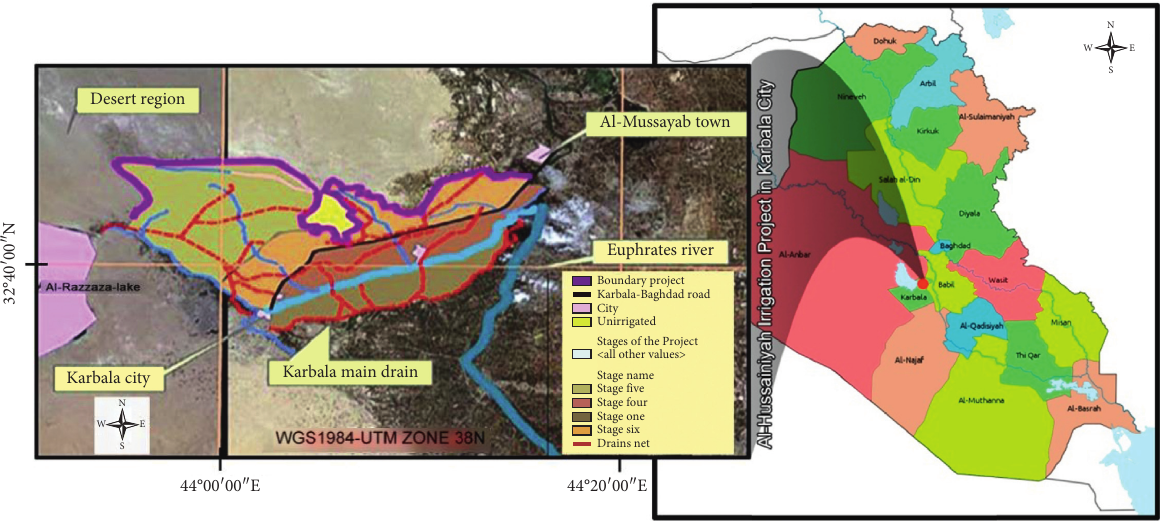
Figure 1: Al-Hussainiyah irrigation project [33]. Table 1: Summary of the average climatic parameters of the study area for the period between 1990 and 2018 [34]. Climatic parameter Mean air